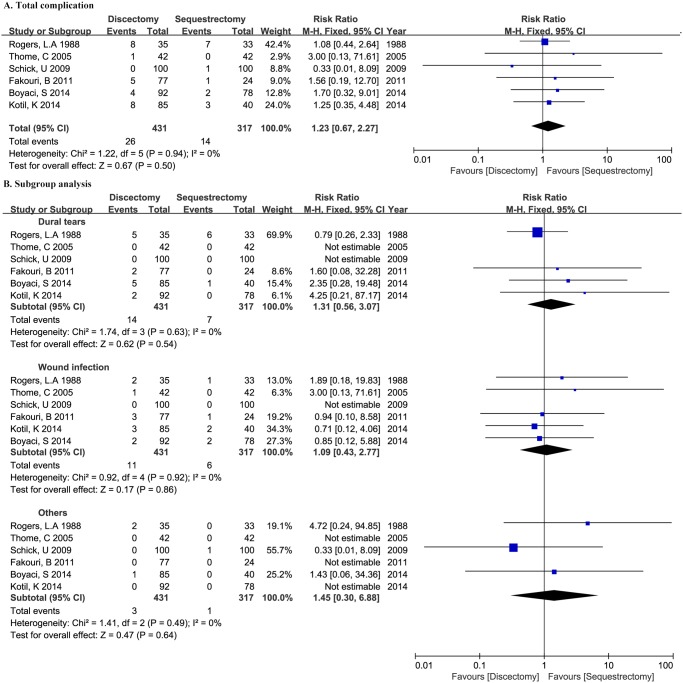
Forest plot illustrating total complication rate (A) and subgroup analysis (B) of meta-analysis comparing discectomy with sequestrectomy.